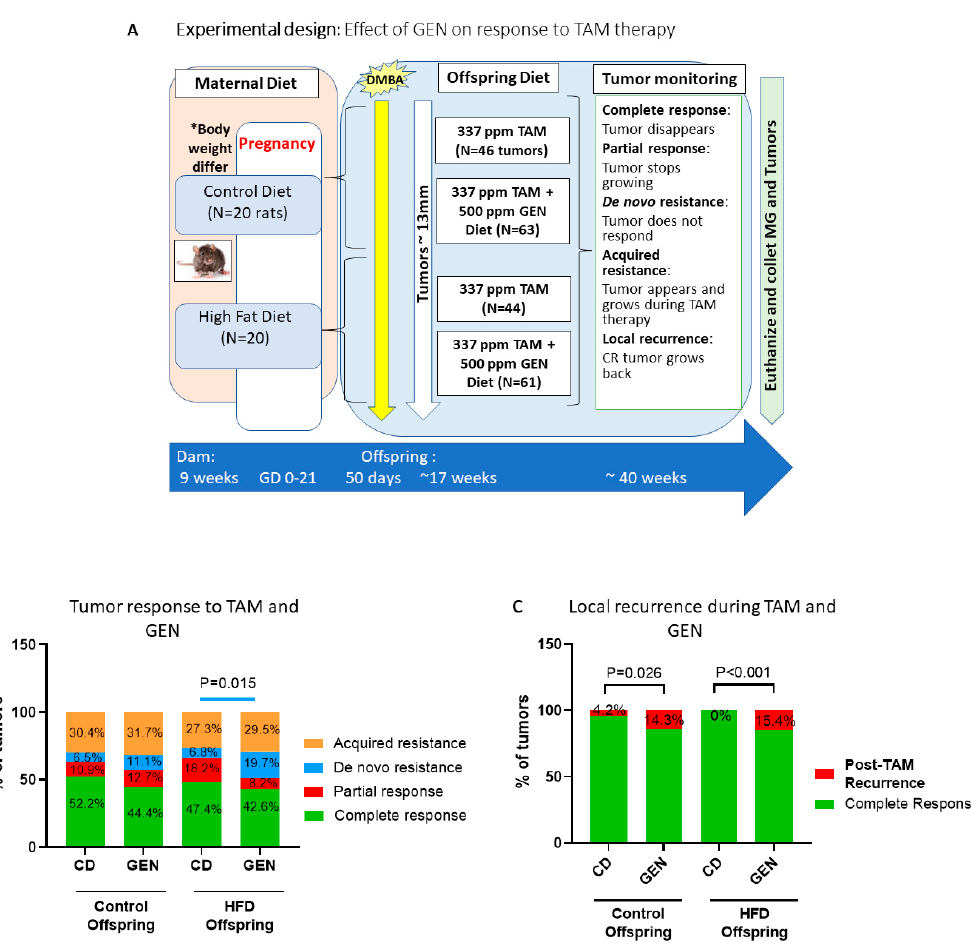
Figure 1. Genistein impairs response to tamoxifen therapy in the high fat diet (HFD) offspring. ( A ) Experimental design to study the effects of starting genistein feeding on tamoxifen responsiveness during therapy on local mammary tumor recurrence in the offspring of control or high fat diet (HFD) fed dams. ( B ) Mammary tumors were defined as complete response (green) when a tumor disappeared for at least six weeks, partial response (red) when a tumor stopped growing or shrunk, de novo resistance (blue) when a tumor never responded, and acquired resistance (orange) when tumor appeared and grew during tamoxifen treatment. Genistein supplementation during tamoxifen therapy significantly increased percentage of de novo resistance tumors among HFD offspring ( p = 0.015). GEN (genistein supplemented) and CD (control diet without supplementation) Control/CD: n = 46 tumors; Control/GEN: n = 63 tumors; HFD/CD: n = 44 tumors, HFD/GEN: n = 61 tumors. ( C ) Genistein significantly increased tumor recurrence in the control offspring (control/GEN; out of 28 tumors, p = 0.026) and HFD offspring (HFD/GEN; out of 26 tumors); p < 0.001) compared to untreated groups (control/CD; out of 24 tumors, and HFD/CD; out of 20 tumors). Statistical significance according to Chi-Square test; * Dams fed HFD had significantly higher weight than control dams before mating ( p = 0.009).